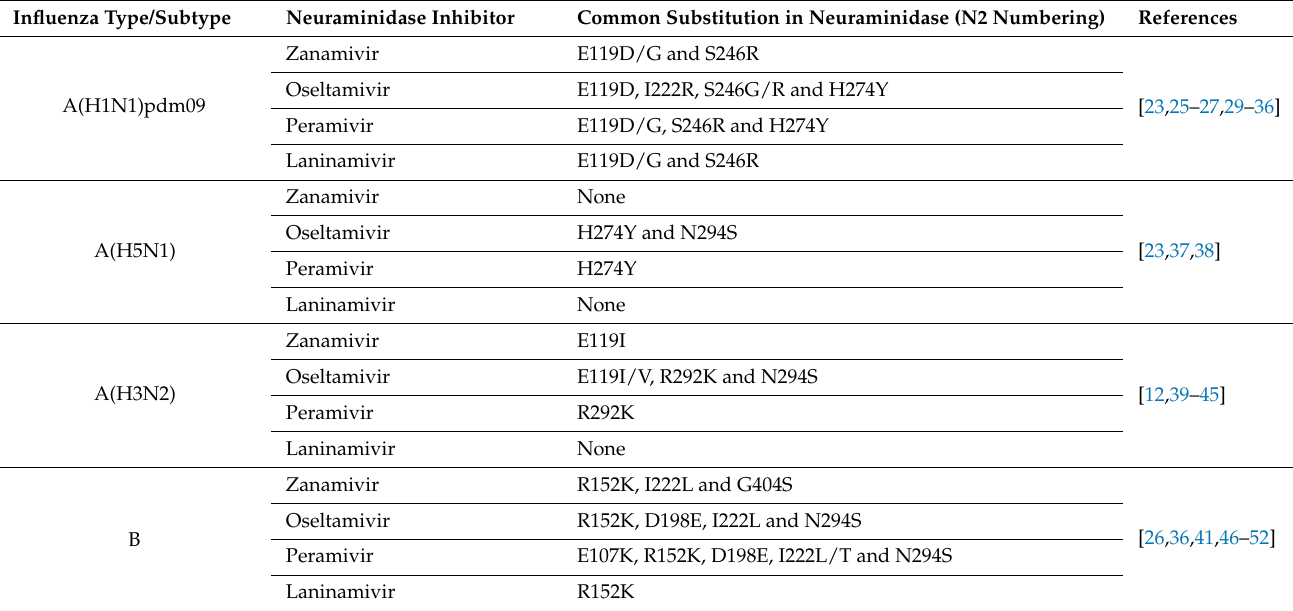
Table 2. Summary of common neuraminidase mutations conferring neuraminidase inhibitor resistance identified in clinical